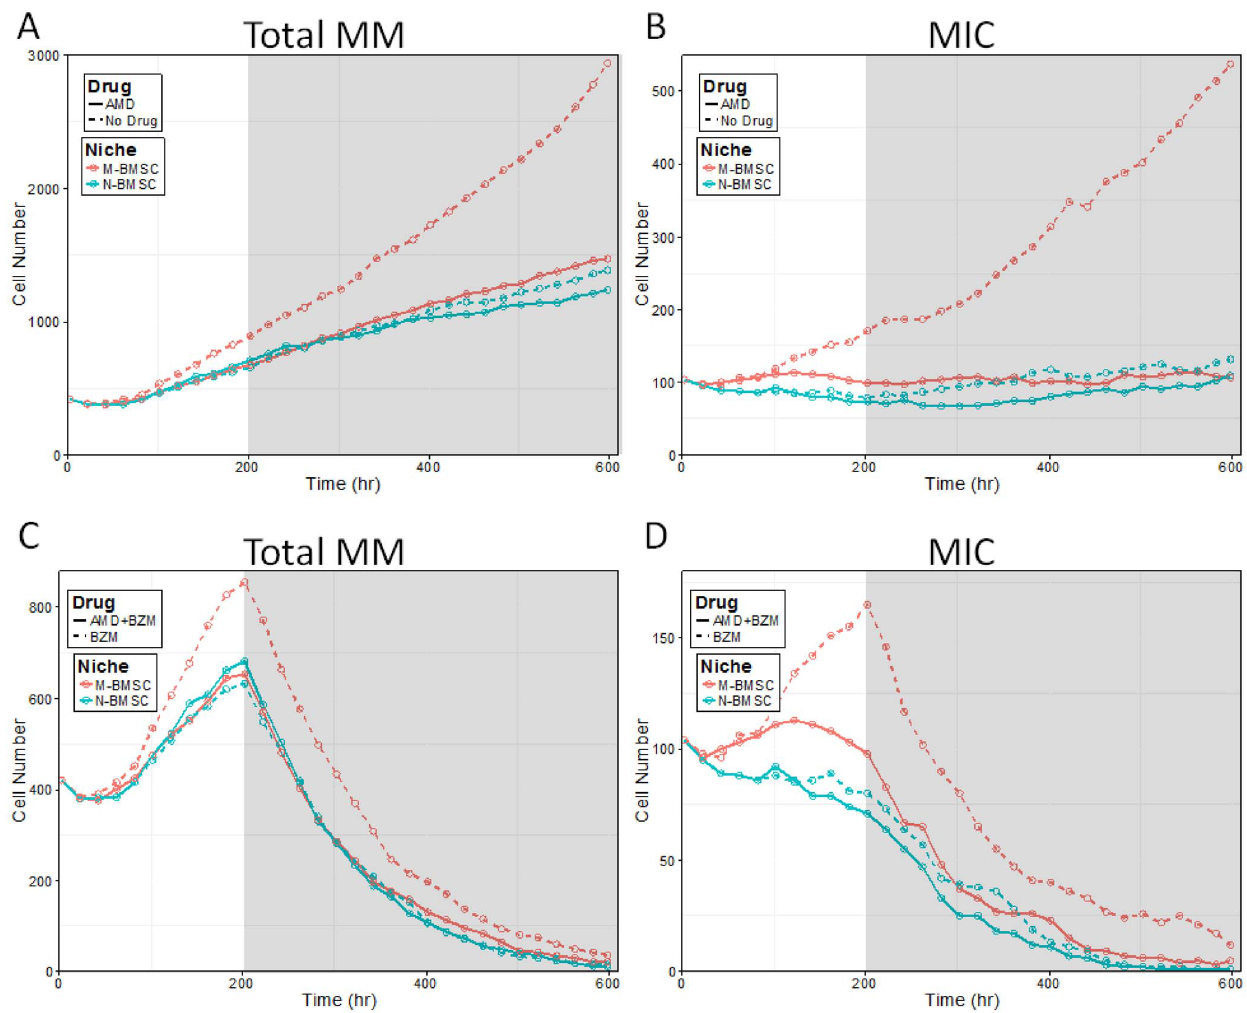
Figure 6. The effects of MIC-BMSC interaction inhibition on tumor growth and the outputs of cytotoxic chemotherapy. (A) The growing trends of tumor cells under MBMSC or NBMSC environment with or without niche inhibitor (AMD3100). (B) The growing trends of MIC cells under MBMSC or NBMSC environment with or without niche inhibitor (AMD3100). (C) The responses of myeloma tumor to cytotoxic drugs under MBMSC or NBMSC environment with or without niche inhibitor (AMD3100). (D) The responses of MICs to cytotoxic drugs under MBMSC or NBMSC environment with or without niche inhibitor (AMD3100). Myeloma-associated or normal BMSC niches were denoted in red or green color, and the effects of the niche inhibitors on tumor growth (A and B) or cytotoxic drug efficacy (C and D) were labeled in solid lines and their controls in dashed lines, respectively.